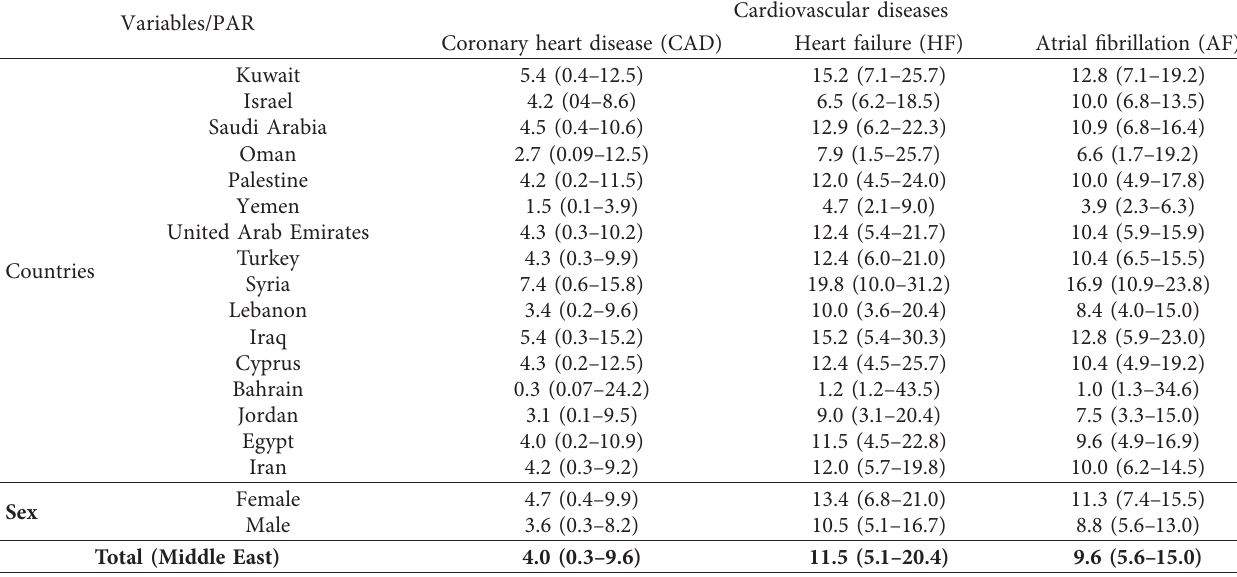
Table 4: Population Attributable Risk for obesity by country and cardiovascular diseases.